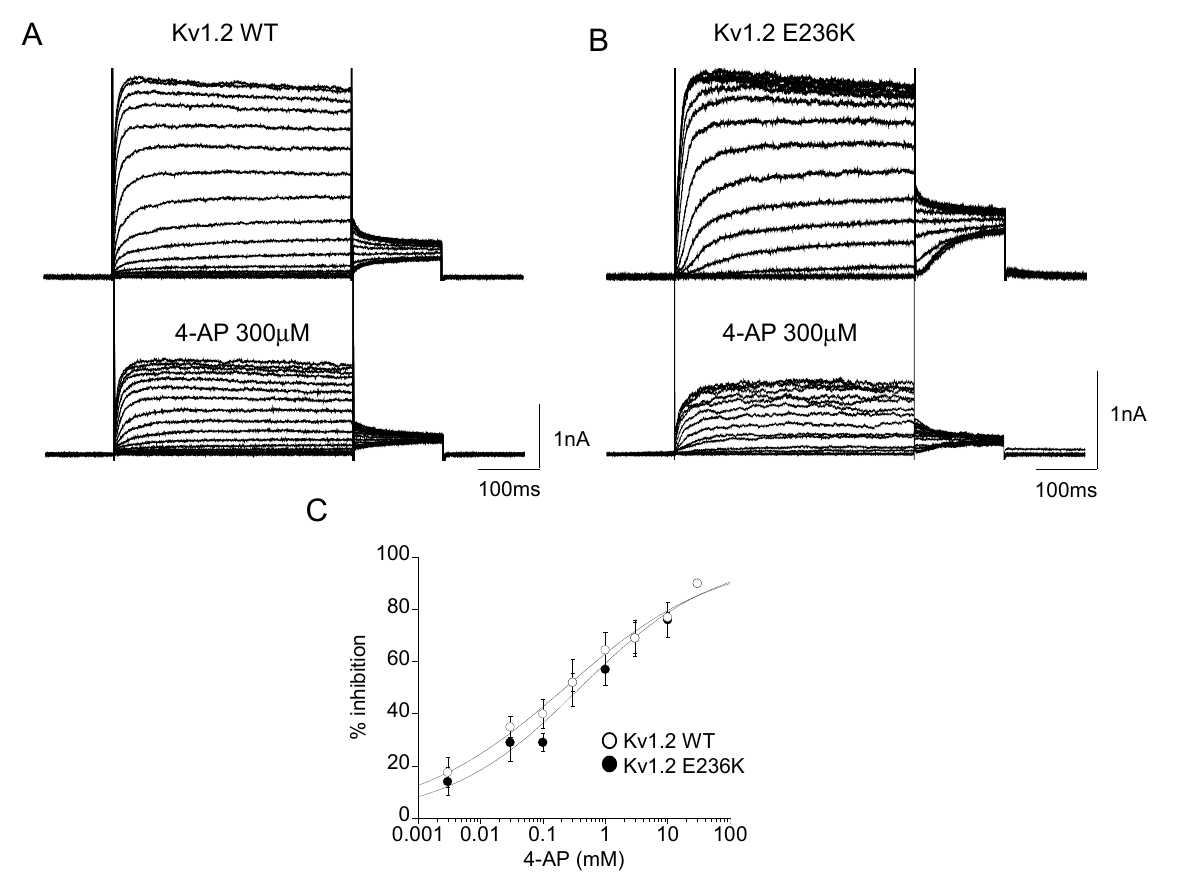
Figure 5. ( A , B ) Representative current traces evoked by 200 ms depolarizing steps from a holding potential of − 80 to +60 mV from Kv1.2 WT ( A ) and E236K ( B ), before and after the application of 4-aminopyridine (4-AP) 300 µ M. ( C ) % of inhibition of potassium current measured at +60 mV as a function of the concentration of 4-AP for Kv1.2 WT and E236K channels. The Hill equation was fitted to the dose-response curves and used to calculate the IC 50 for each channel type ( n = 4 cells/dose).